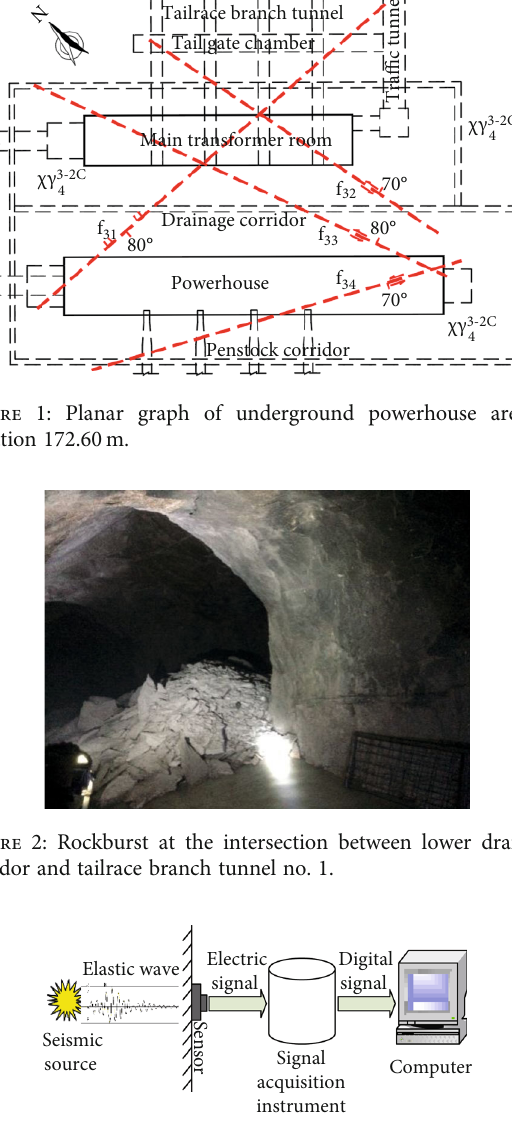
Figure 3: Schematic diagram of the principle of microseismic monitoring.